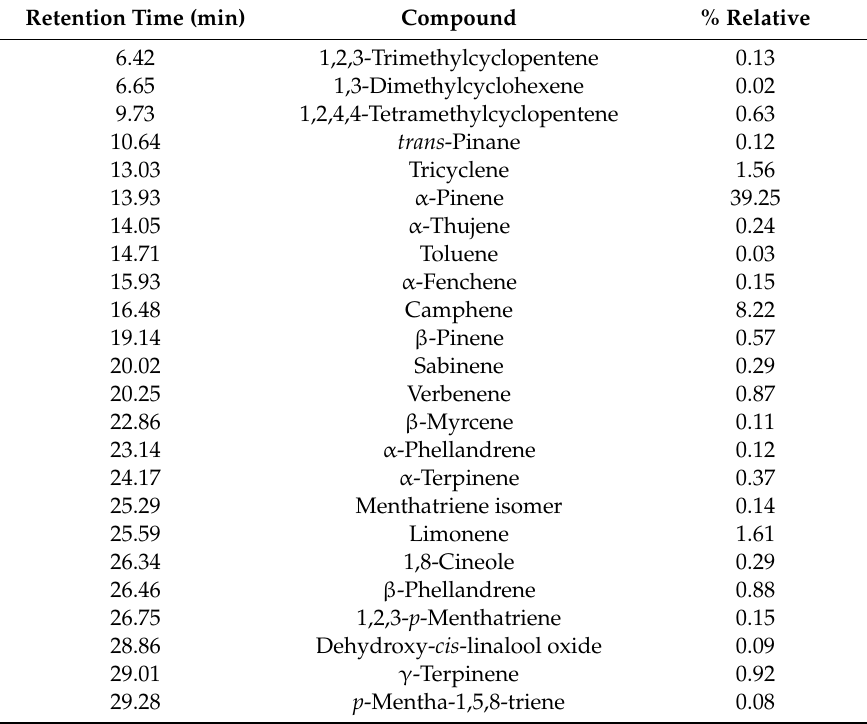
Table 1. Chemical composition of rockrose